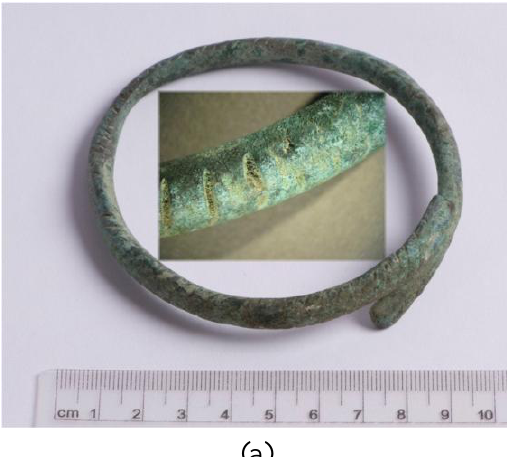
Figure 3. Archaeological artworks made of copper alloys: (a) bracelet; (b) fibula, property of the Jasna Góra Monastery, Częstochowa; (c-d) bows, property of the Wilanów Palace Museum in